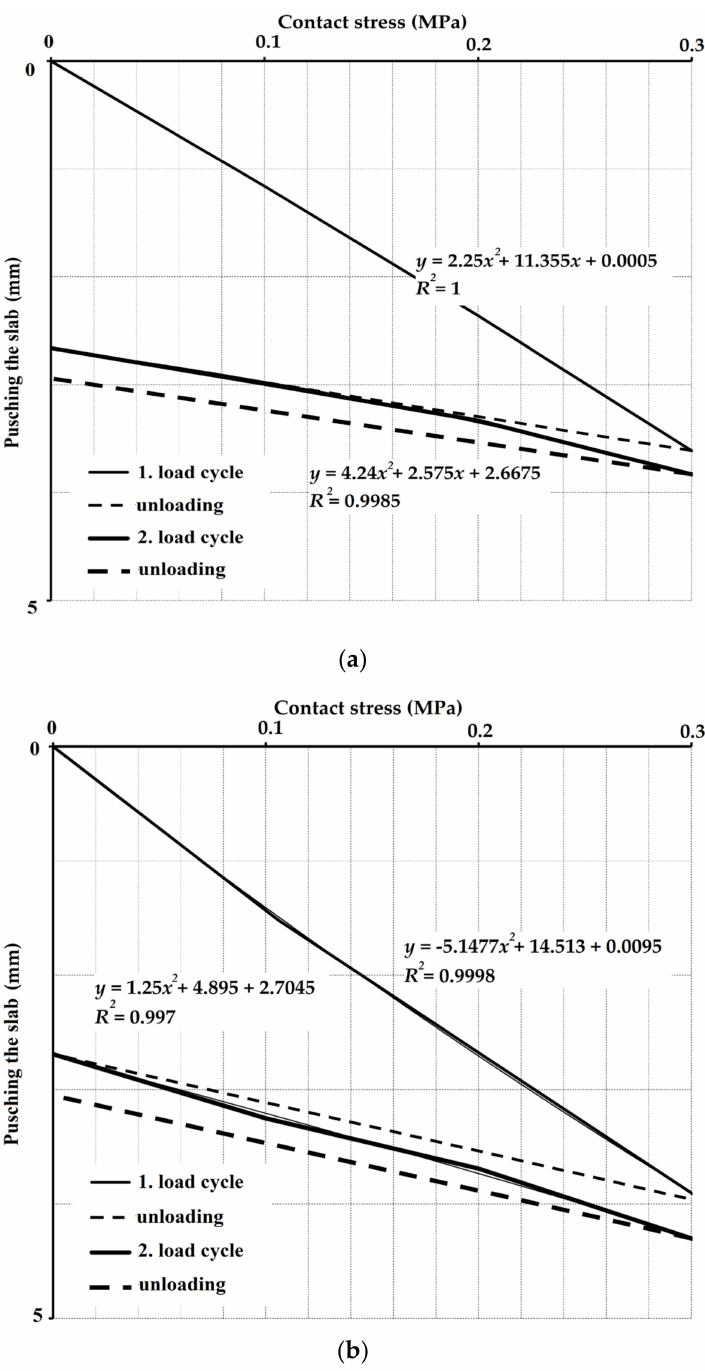
Figure 9. Dependence of pushing the slab on contact stress—hysteresis loops: ( a ) before concreting the centrically loaded slab G10, e = 1.50 m; ( b ) before concreting the centrically loaded slab G10, e =